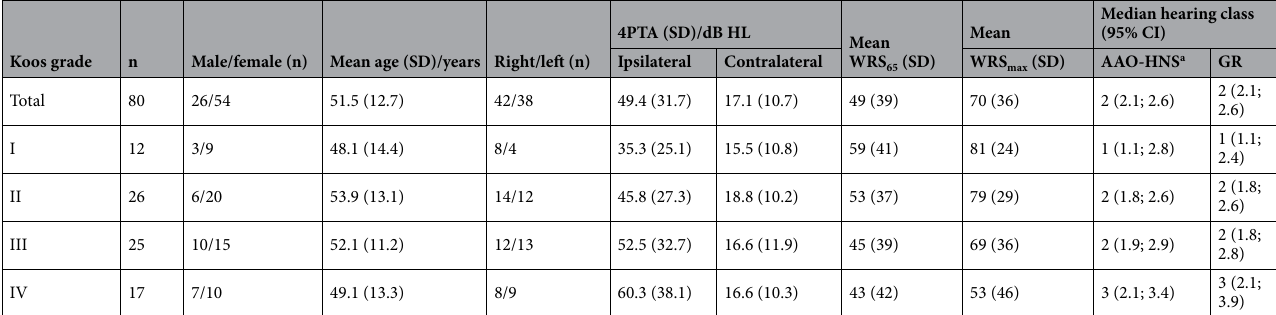
Table 2. Demographic and audiological details of tumor patients. a 1 = A, 2 = B, 3 = C, 4 = D; SD standard